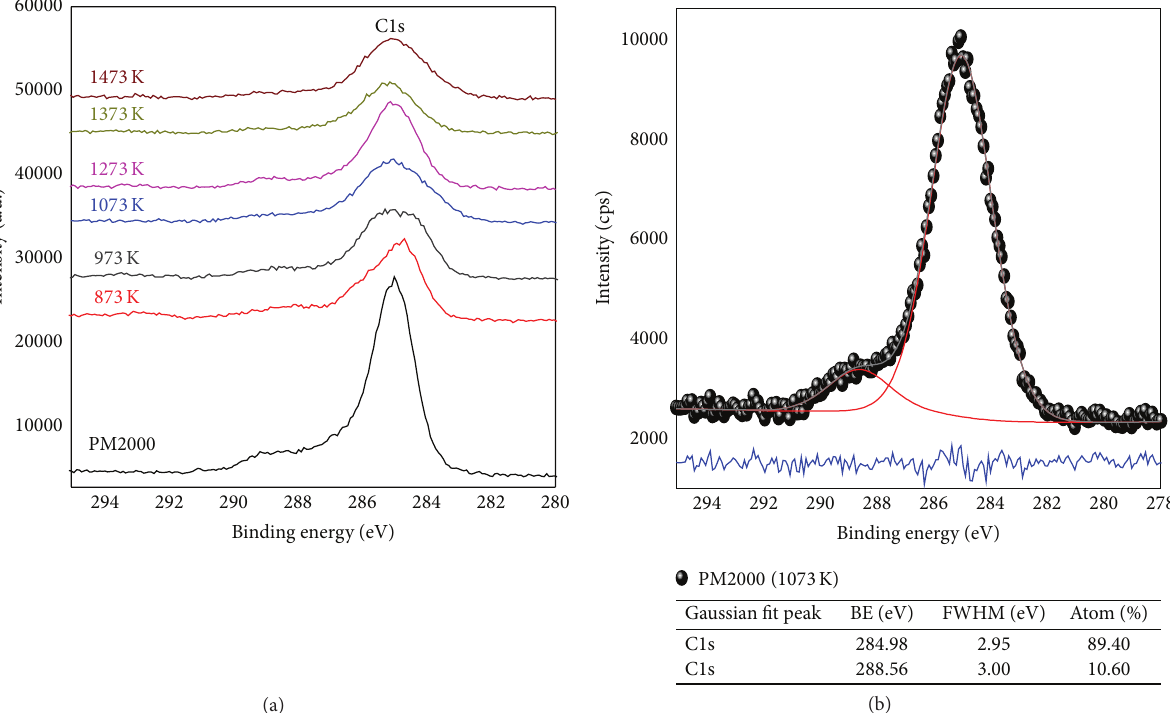
Figure15:XPSspectraintheC1sregionfortreatedandas-receivedPM2000atvarioustemperatures(a)anddecomposedC1speakofoxidized PM2000 at 1073 K